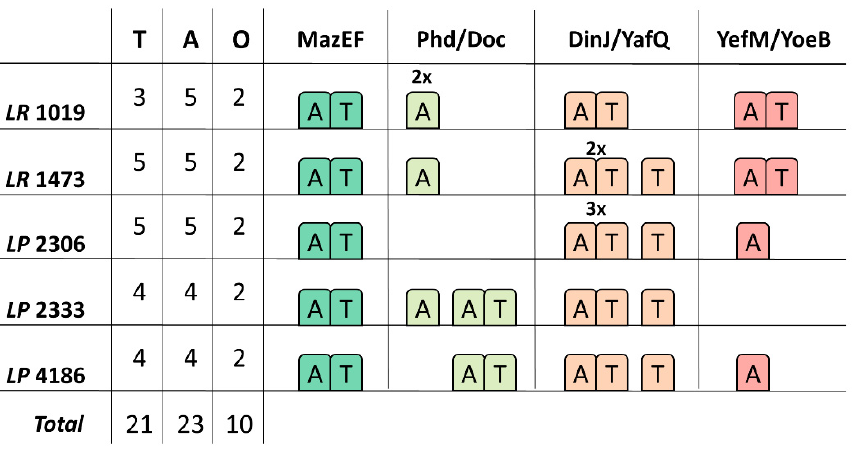
Figure 5. Distribution and organization of the identified type II TA systems. The left part of the figure summarizes the distribution of toxins (T), antitoxins (A) and number of TA systems not organized in pairs, that can be considered as “orphans” (O) in the Lacticaseibacillus isolates. The right part of the figure shows the organization of the identified TA systems in the strains. A superimposed number indicates that multiple copies were found in the genome. Abbreviations in strain names are as follows: LP: L. paracasei , LR: L. rhamnosus .